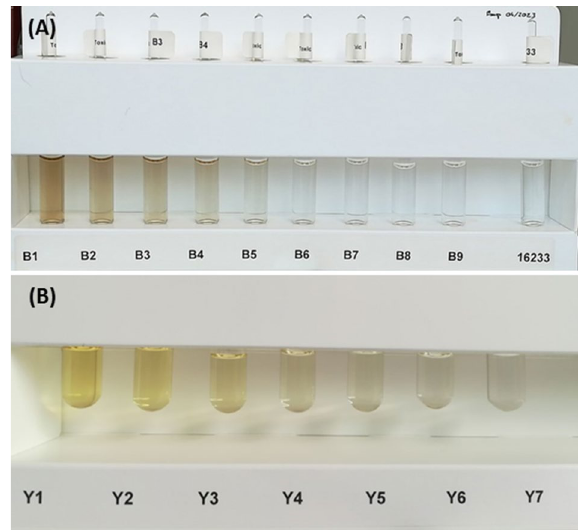
Figure 1. European Pharmacopeia color reference range solutions used for visual examination: ( A ) set of color B (brown) and ( B ) set of color Y